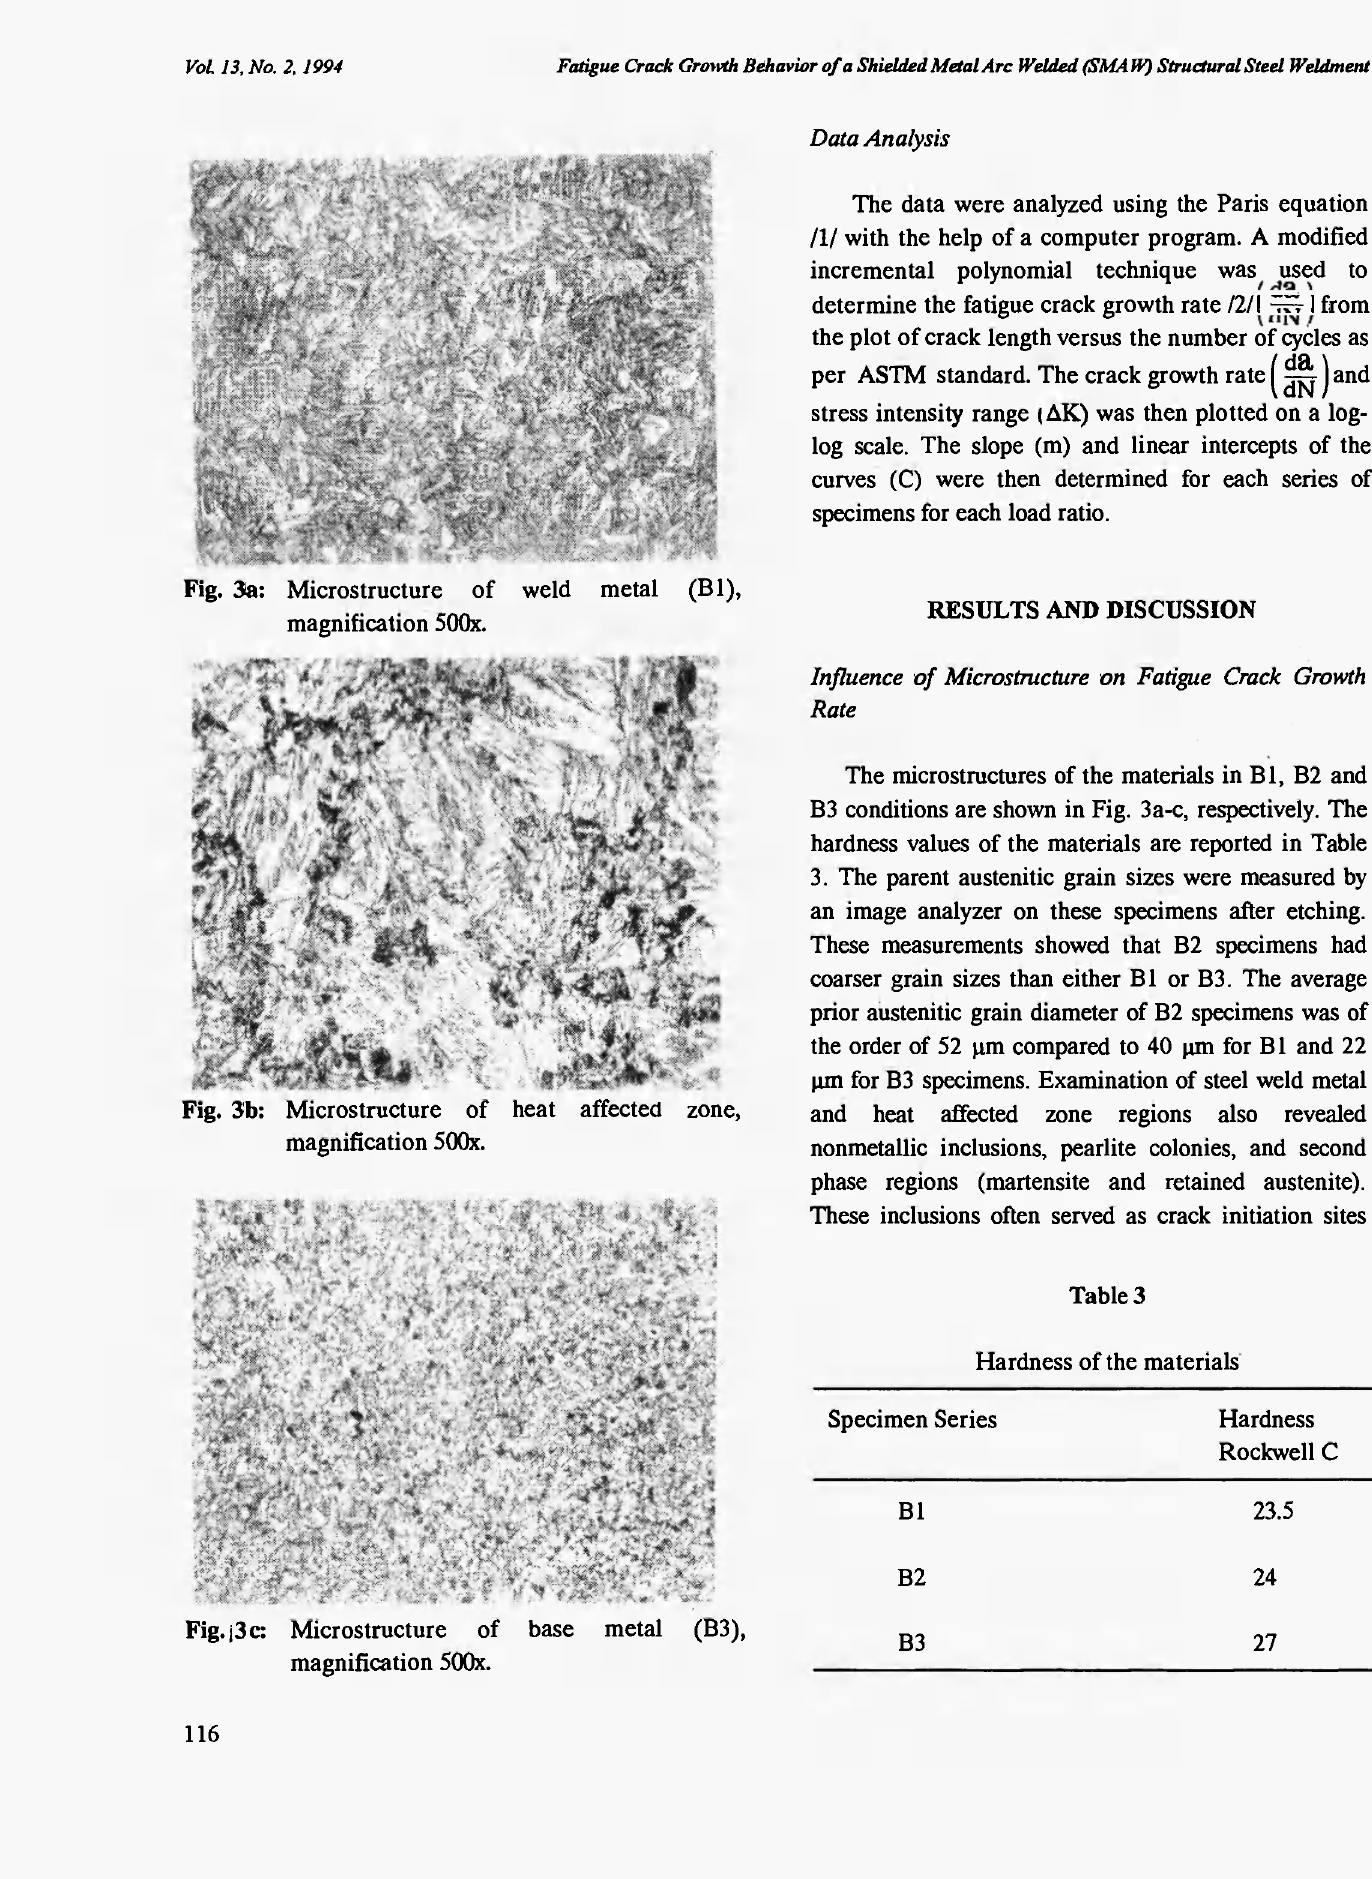
Fig.j3c: Microstructure of base metal (B3), magnification 500x.